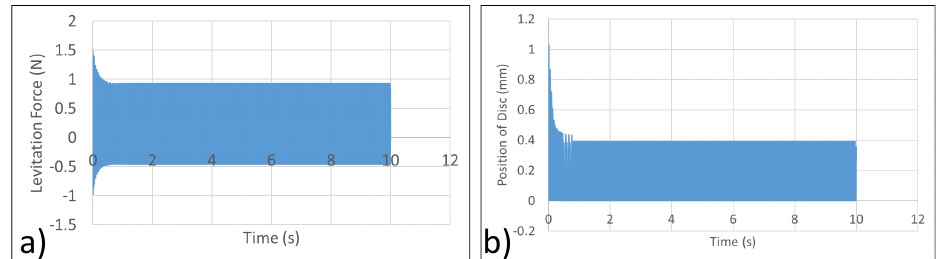
Figure 9. Simulation data from ANSYS Maxwell. ( a ) Levitation force vs. Time. ( b ) Position of disc vs.